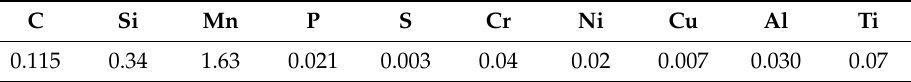
Table 1. The chemical composition of X70 pipeline steel